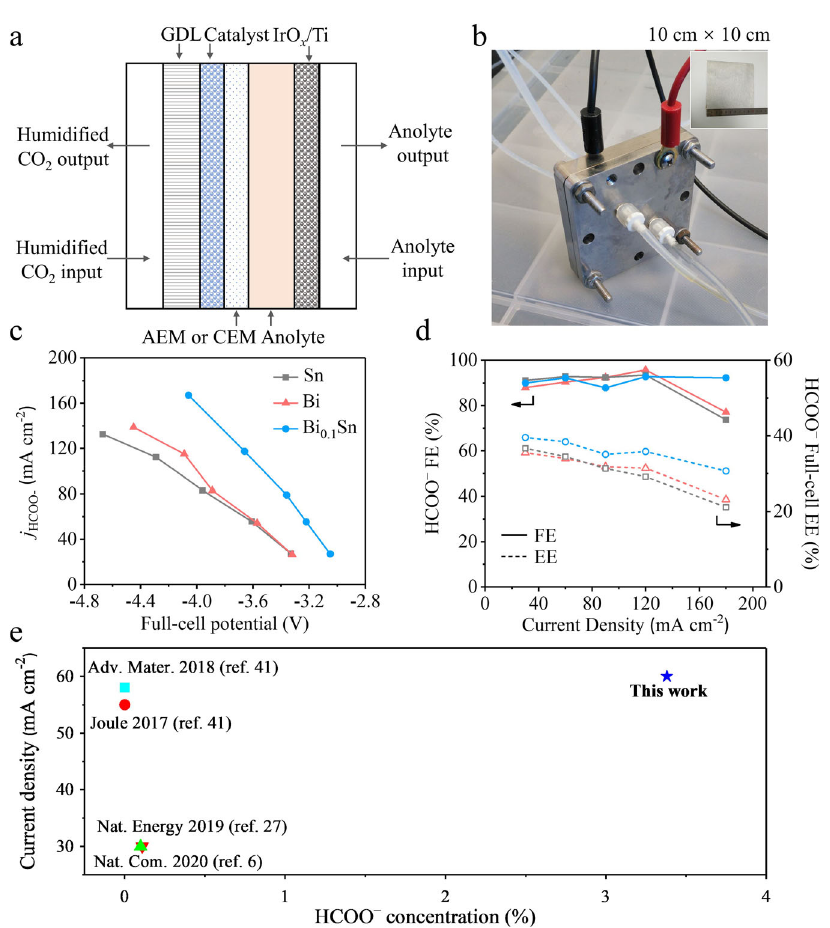
Fig. 5 CO 2 electroreduction performance in anion-exchange membrane (AEM)-based MEA systems. a Schematic of the MEA con fi guration. b The optical image of an MEA device. c Current densities vs. applied potentials of Bi, Sn, and Bi 0.1 Sn in AEM-based MEA systems. d HCOO – FEs and EEs of Bi, Sn, and Bi 0.1 Sn at different current densities in AEM-based MEA systems. e Comparison of our data with literature benchmarks (We plot the concentration values obtained in the longest duration tests in each